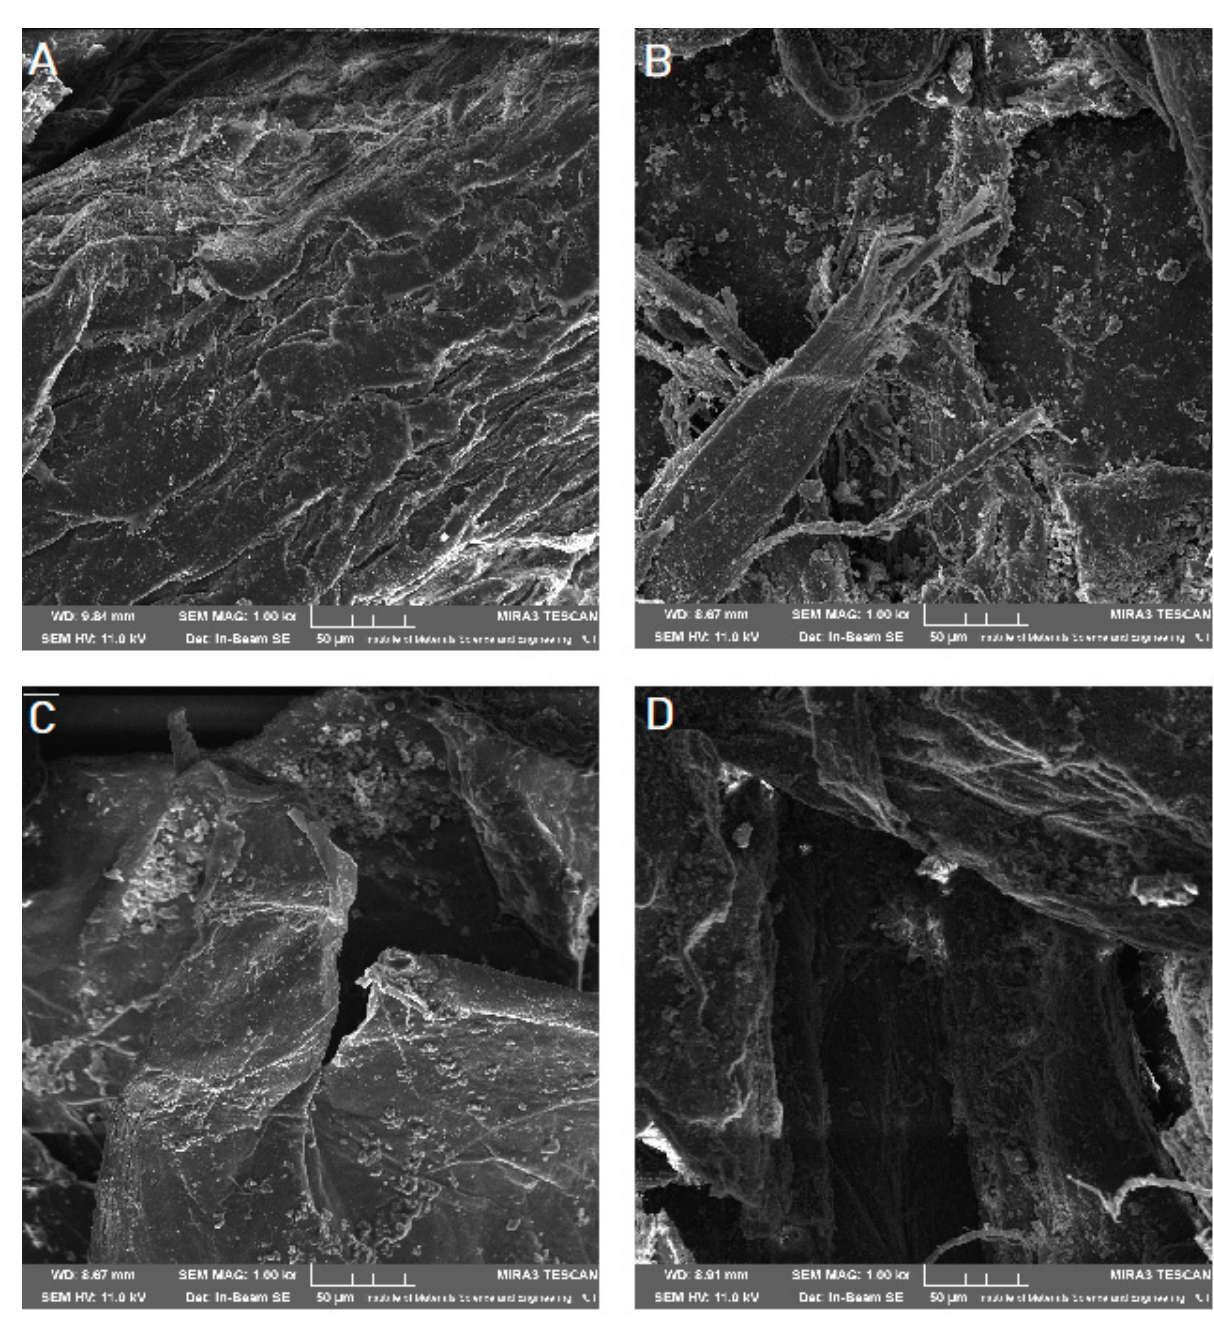
Figure 6. SEM images of chitosan 80/500 ( A ) and its system with CVD in a weight ratio: 1:1 ( B ), 1:5 ( C ), 1:10 ( D ) at 1000× magnification.